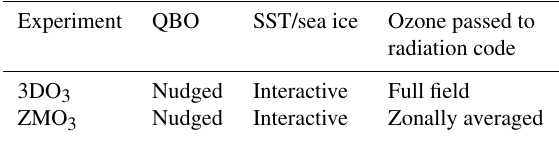
Table 1. The model setup for the 3DO 3 and ZMO 3 experiments. SST indicates sea surface